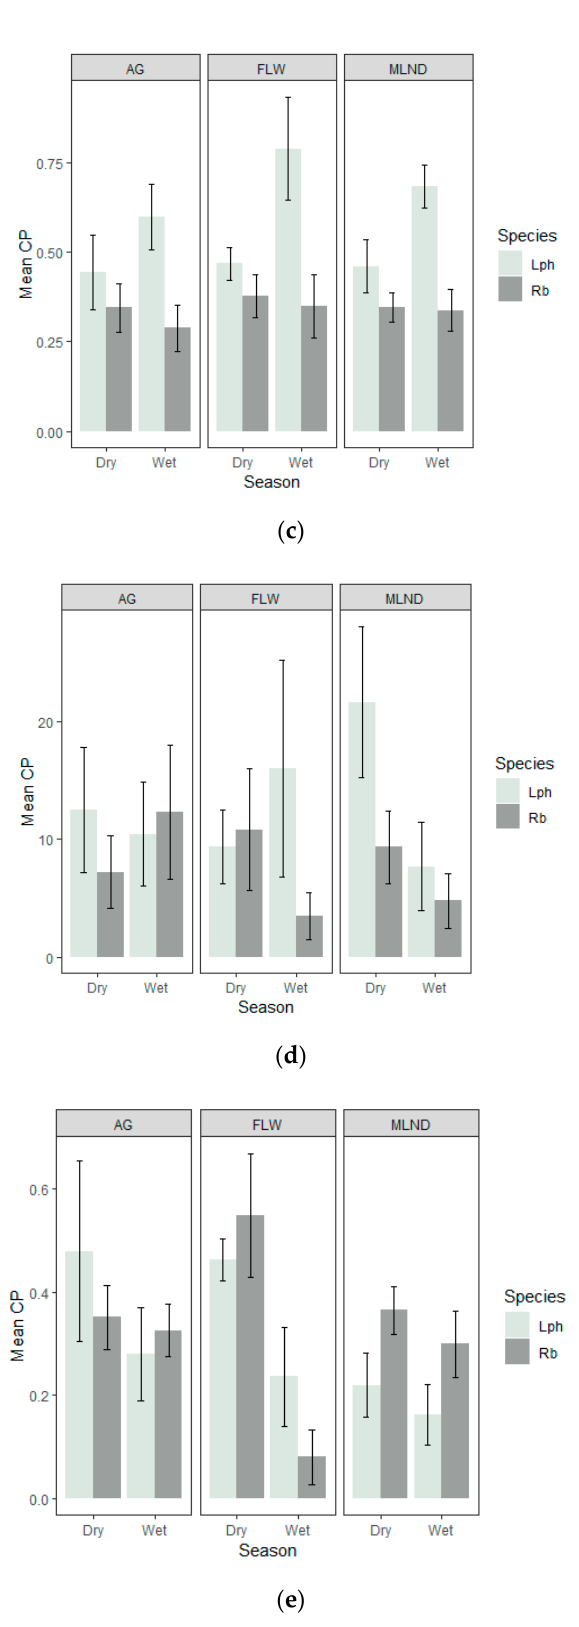
Figure 2. Mean percentage occurrences (CP) for vegetative materials ( a ), seeds/starch ( b ), invertebrates ( c ), roots ( d ), and hair ( e ) of the two rodent species across habitats and seasons. Abreviations: AGR: agricultural fields; FLW: fallow land; MLD: moorland; Lph: Lophuromys acquilus ; Rb: Rhabdomys dilectus.